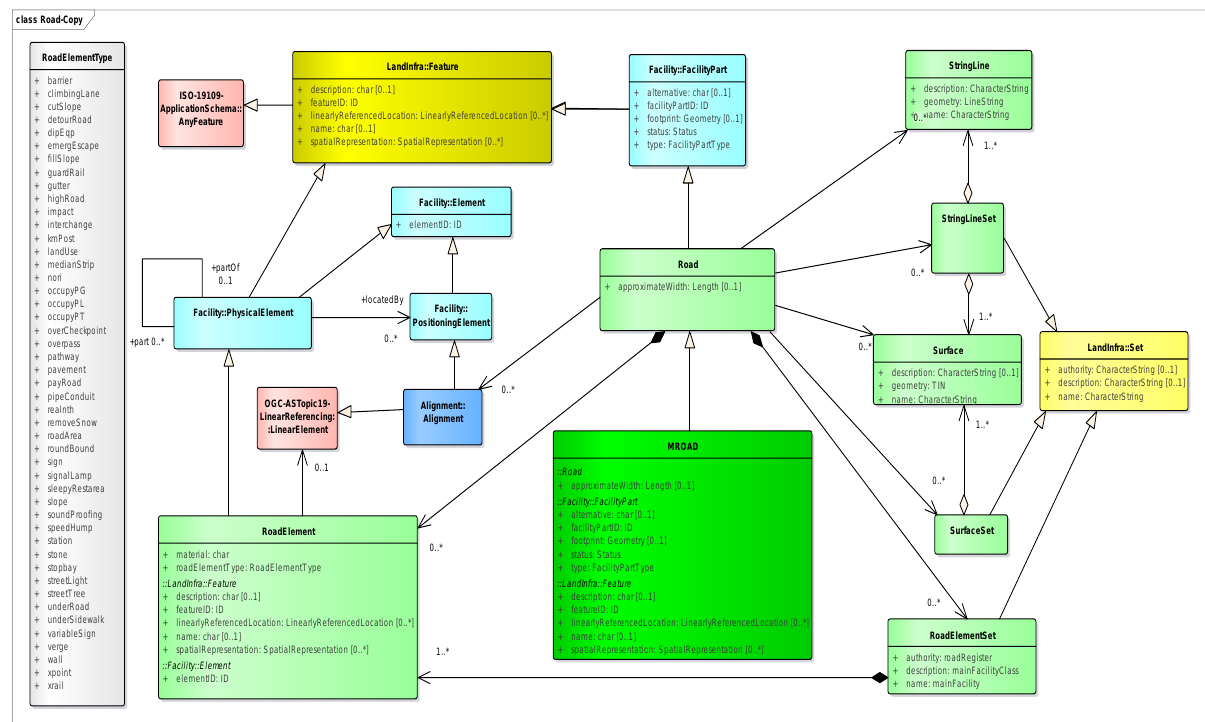
Figure 5. Proposed data model of the road register based on Road part of